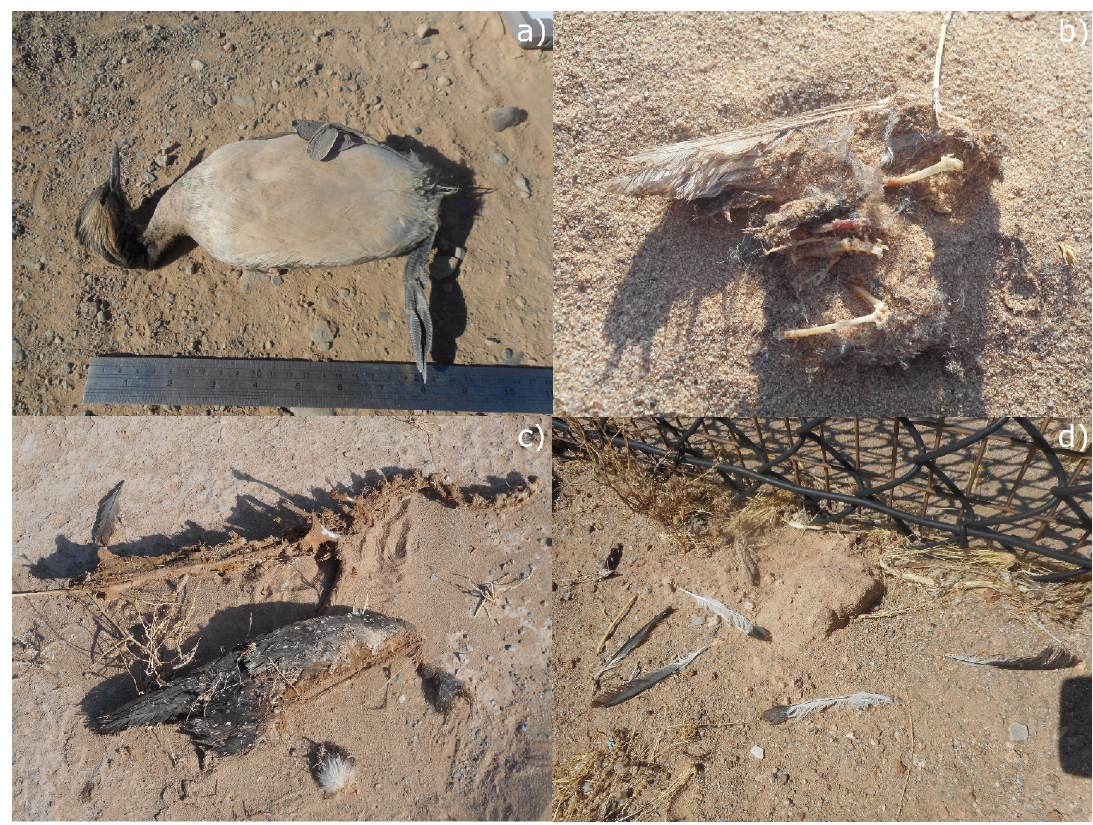
Fig 1. Examples of an intact carcass (a), partial carcass (b, c), and feather spot (d) found at PV USSE facilities in the Southwestern